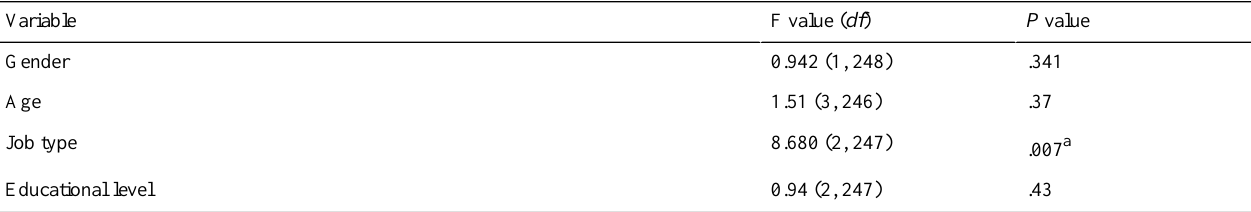
Table 6. ANOVA test of